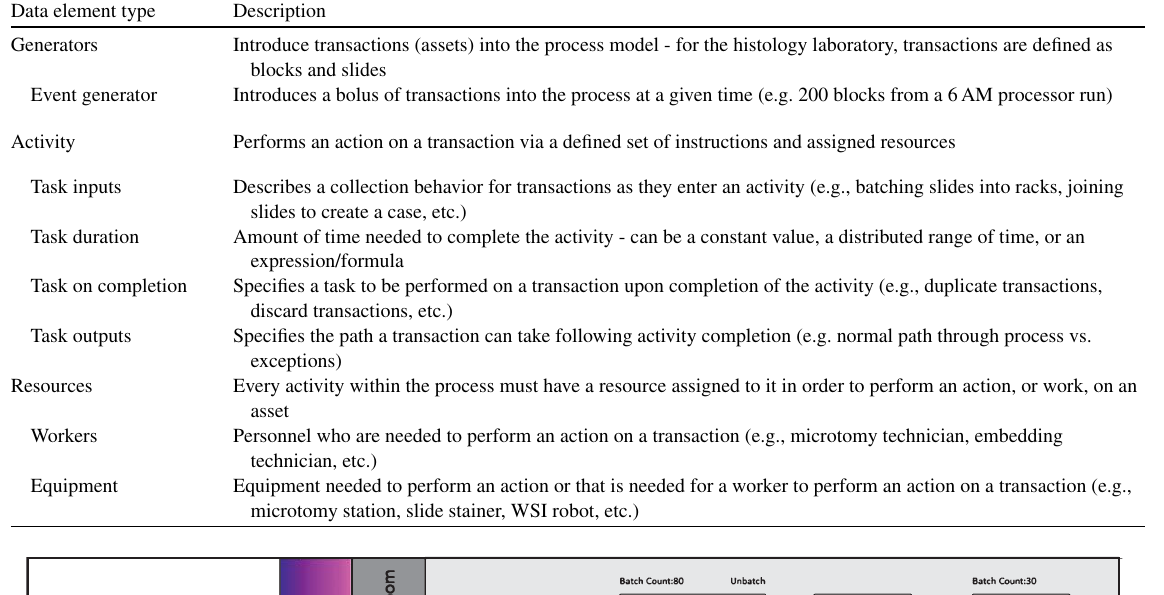
Data elements used for process modeling